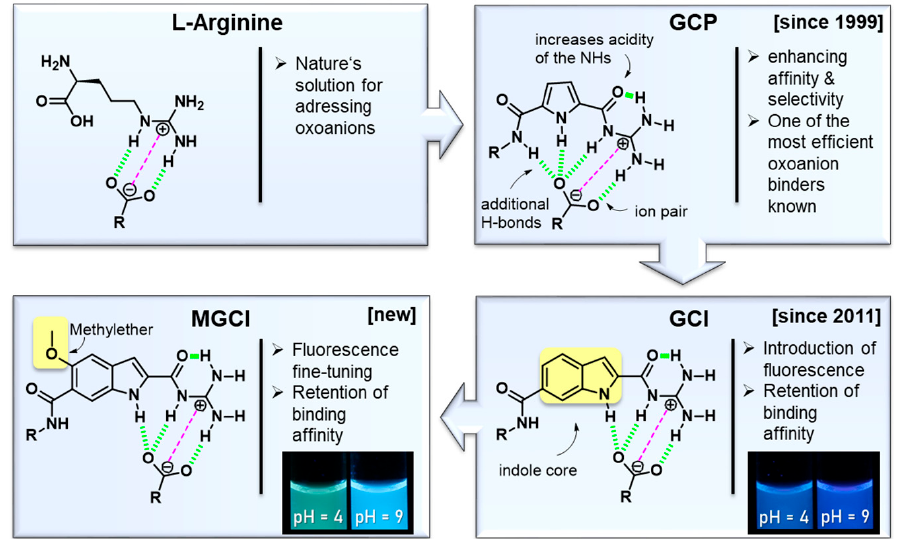
Figure 1. Schematic representation of the evolution of artificial arginine analogues from guanidinocarbonyl-pyrrole (GCP) to guanidinocarbonyl-indole (GCI) and methoxy- guanidinocarbonyl-indole (MGCI).